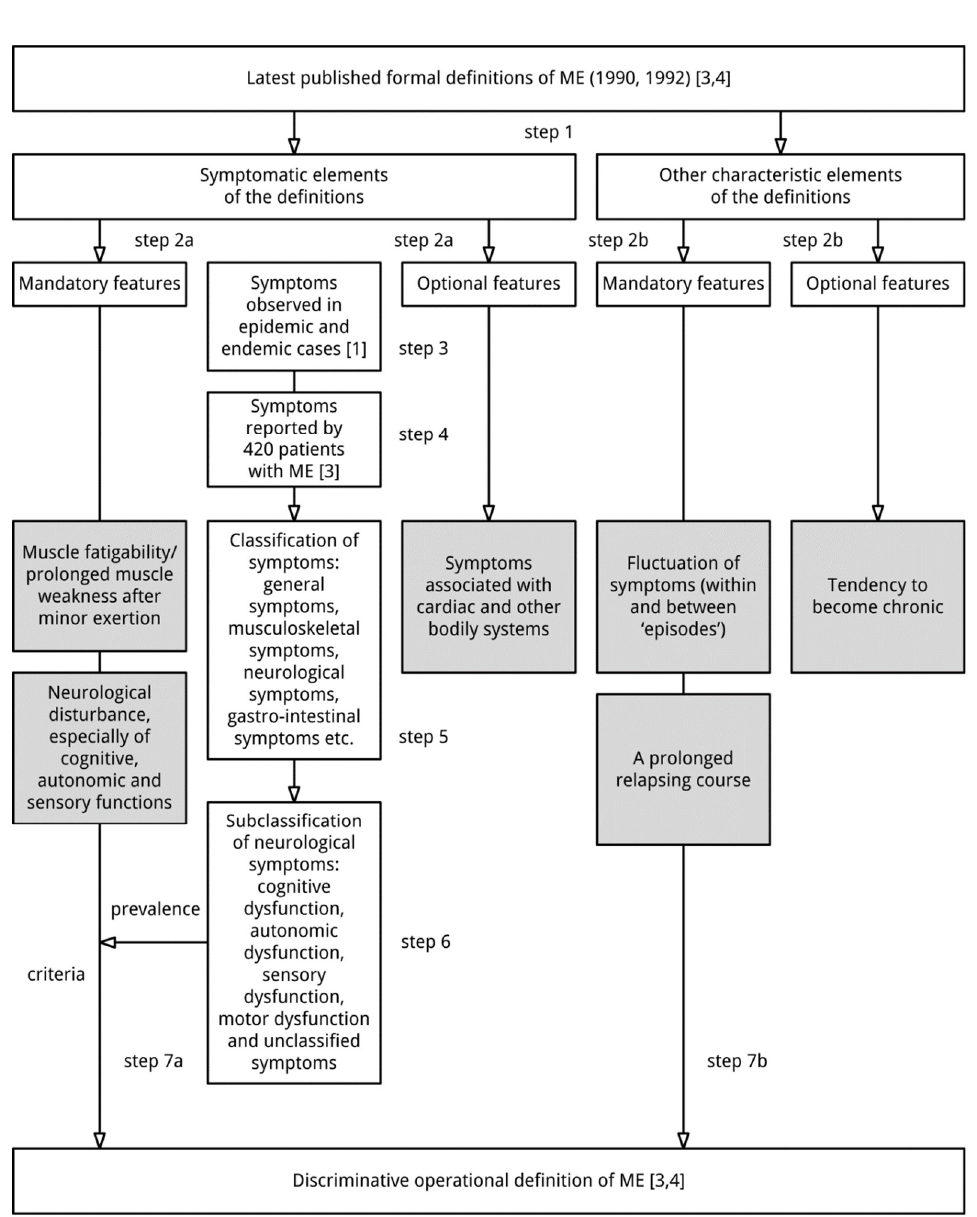
Figure 1. Method. Figure 1.